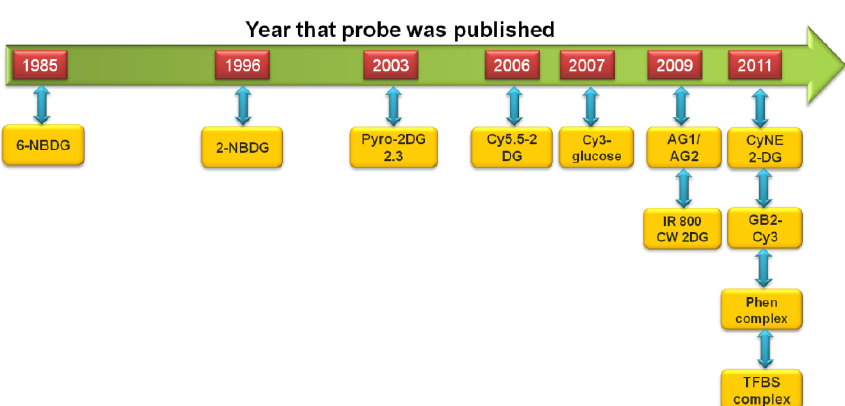
Figure 1. Timeline to show that research aimed at the development of fluorescent-tagged glucose bioprobes is increasing. Each new published probe is shown as a yellow